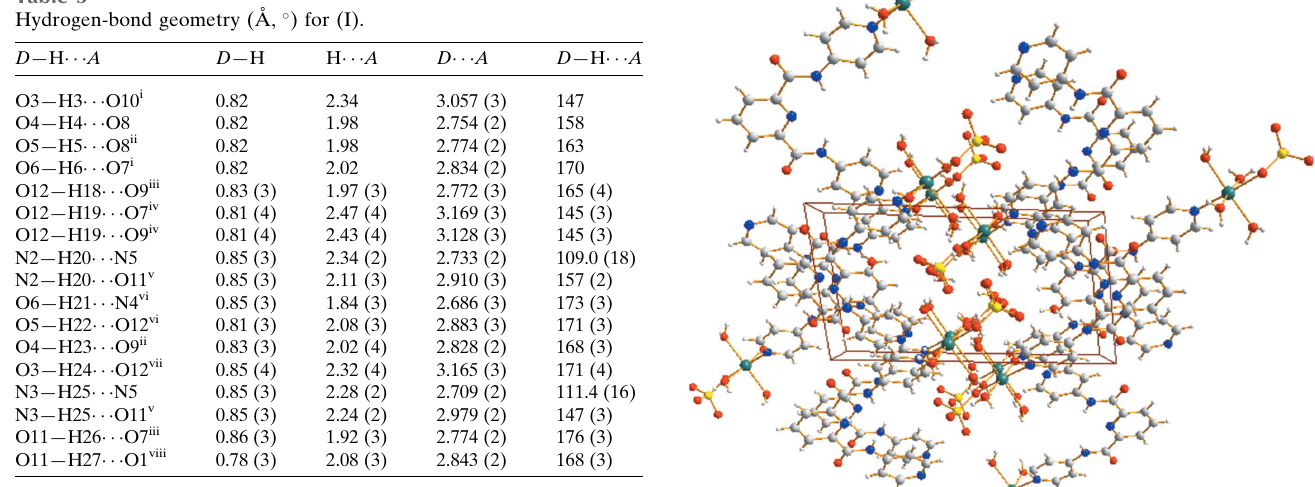
Table 4 Hydrogen-bond geometry (A˚ , (cid:3) ) for (II).